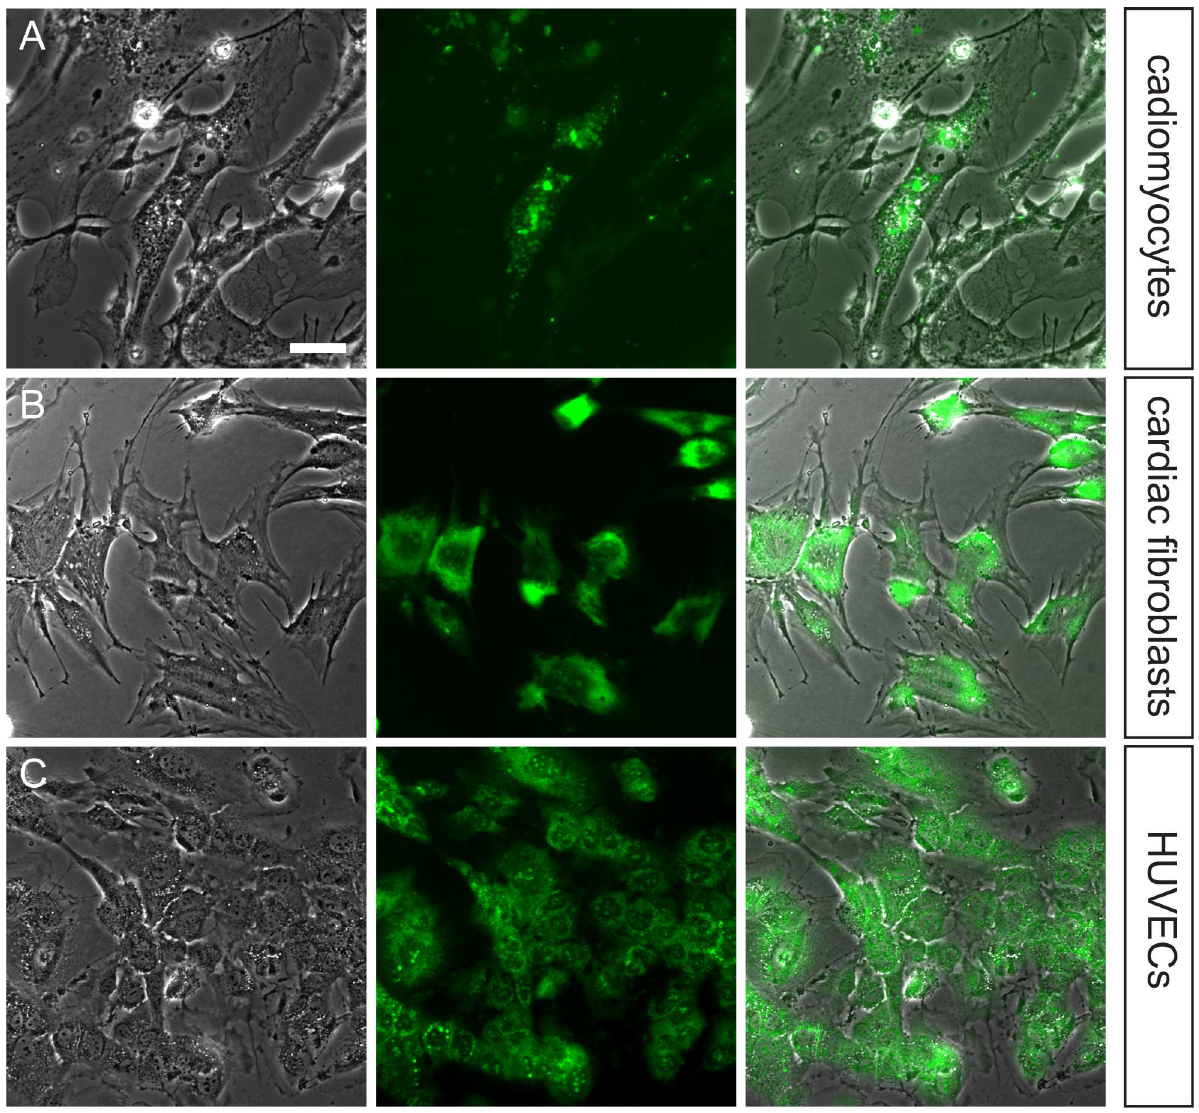
Fig 3. Differential Effect of CDC-derived exosomes are internalized by cardiomyocytes, cardiac fibroblasts and HUVECs. Isolated CDC-derived exosomes labeledwith Exo-Red (nucleic acid label) were incubatedwith (A) cardiomyocytes, (B) cardiac fibroblasts, and (C) HUVECs for 6 hours and imagedto show cellular uptake. The frequencyof hCDC-derived exosome uptake was lower for cardiomyocytes than endothelialcells or fibroblasts. Scale bar 50 μ m.